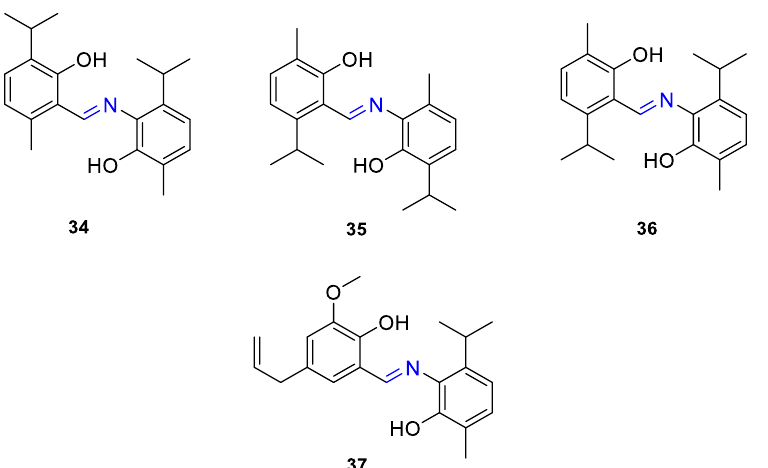
Figure 18. Phenolic monoterpenoids based azomethine scaffolds.